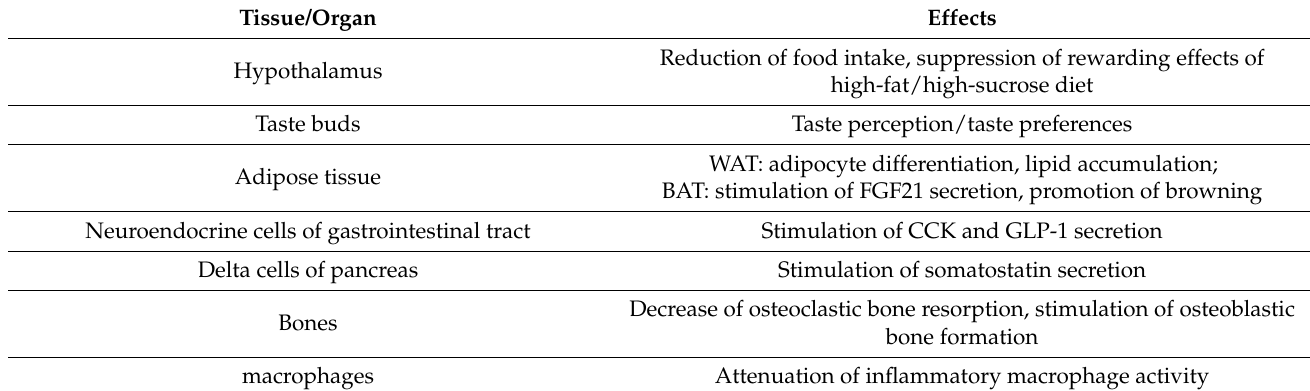
Table 2. A summary of physiological effects of FFAR4 stimulation in various tissues and organs. Based on [3,11,17].